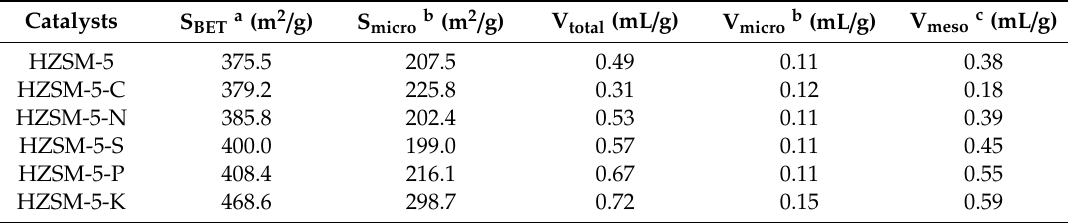
Figure 3. N 2 adsorption-desorption isotherms of the synthesized HZSM-5 zeolites. Table 2. Physical properties of HZSM-5 synthesized with different additives.